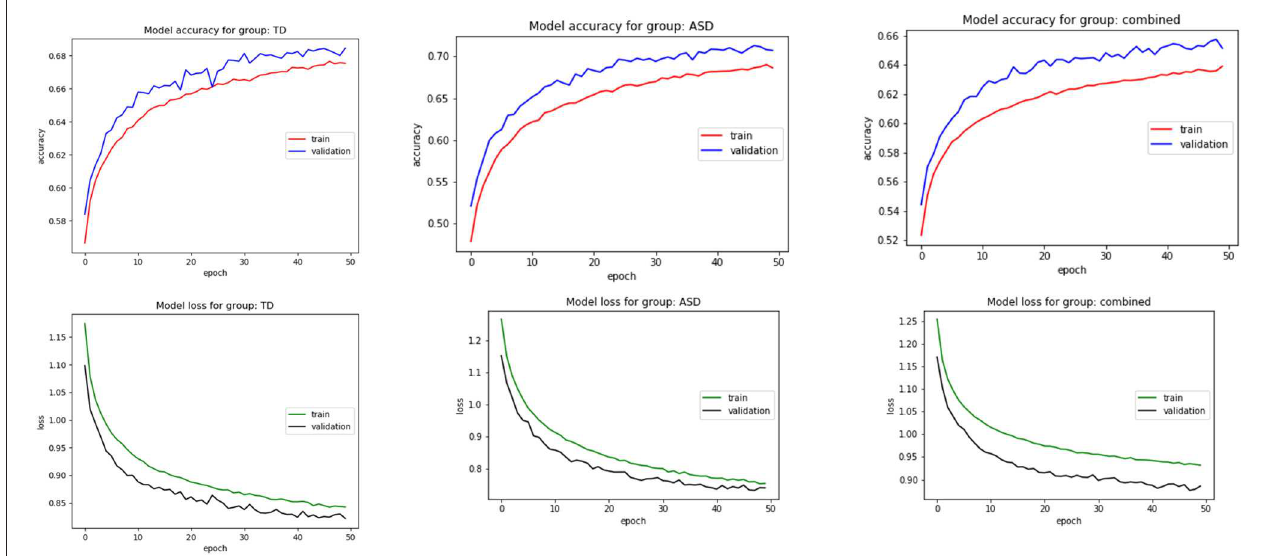
FIGURE 8 | Plots showing the ground truth labels in red and the classifier predictions in blue.